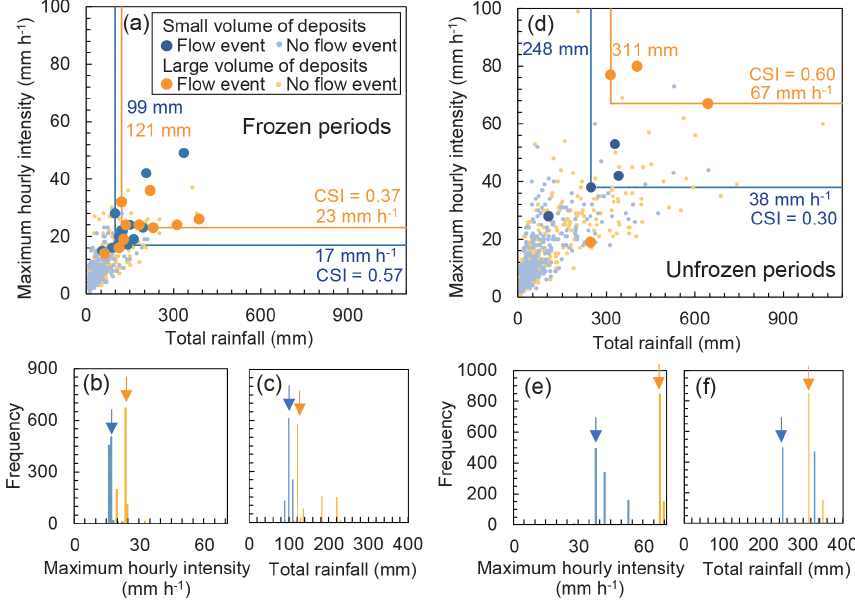
Figure 12. Comparison of the total rainfall and maximum hourly rainfall in rainfall events with or without debris flows and slush avalanches, plotted according to the volume class of channel deposits. The boundary between the two volume classes was set to 350000m 3 . (a) Com- parison during frozen periods. The lines in the plots indicate the rainfall thresholds that optimally separated rainfall events that induced debris flows and slush avalanches from those that did not. Frequencies of (b) maximum hourly rainfall intensity and (c) total rainfall, which produced the highest critical successful index (CSI), obtained by 1000 bootstrap resamplings during frozen periods. (d) Comparison during unfrozen periods. Frequencies of (e) maximum rainfall intensity and (f) total rainfall obtained by bootstrap